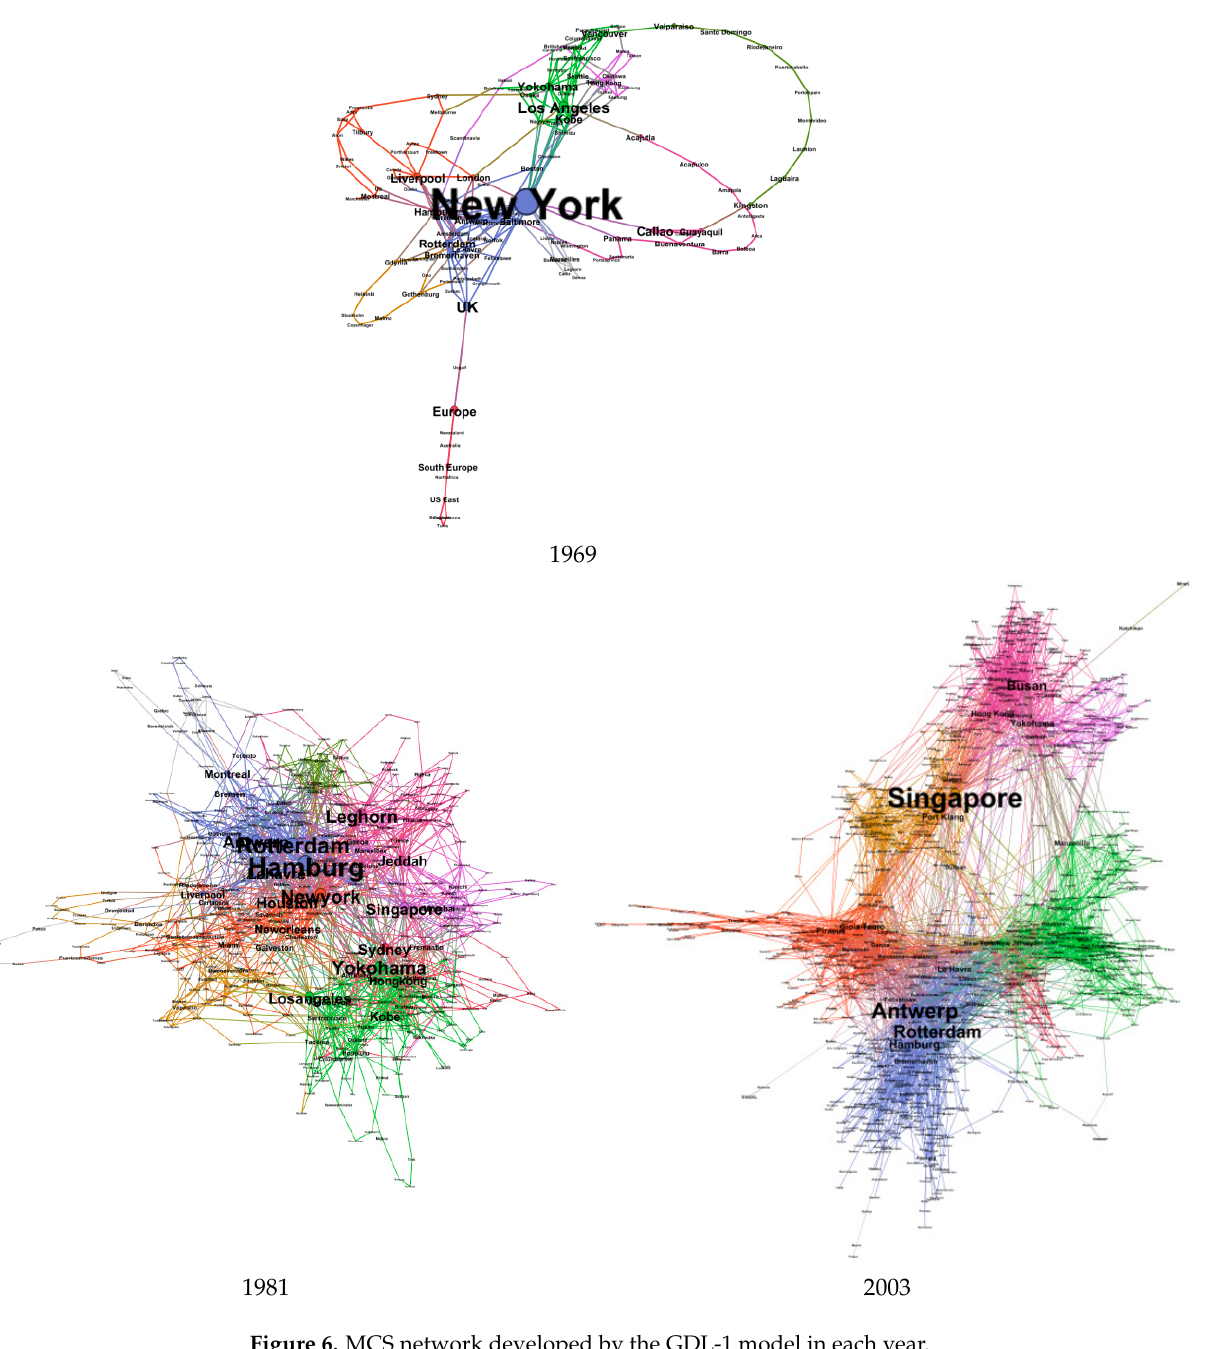
Figure 6. MCS network developed by the GDL-1 model in each year.